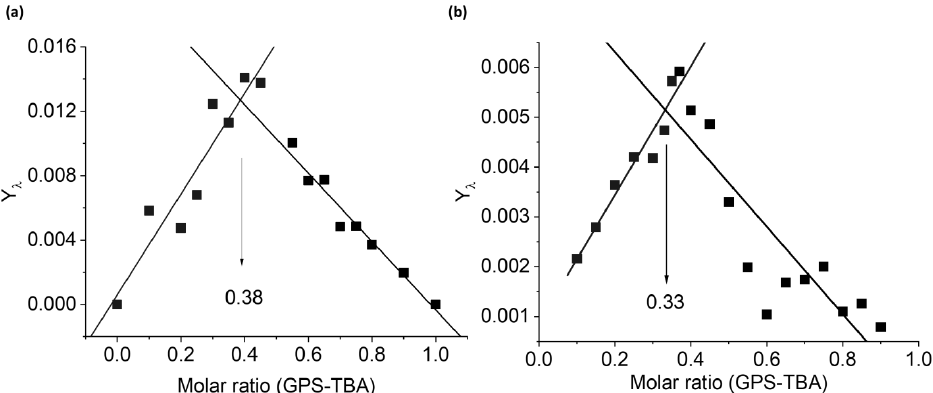
Figure 3. Job plots for the titration of I with GPS-TBA in ( a ) CHCl 3 and ( b ) MeCN, showing the contribution of I -GPS-TBA complex to the absorption signal (Y λ ), plotted against the molar ratio of GPS-TBA in solution.